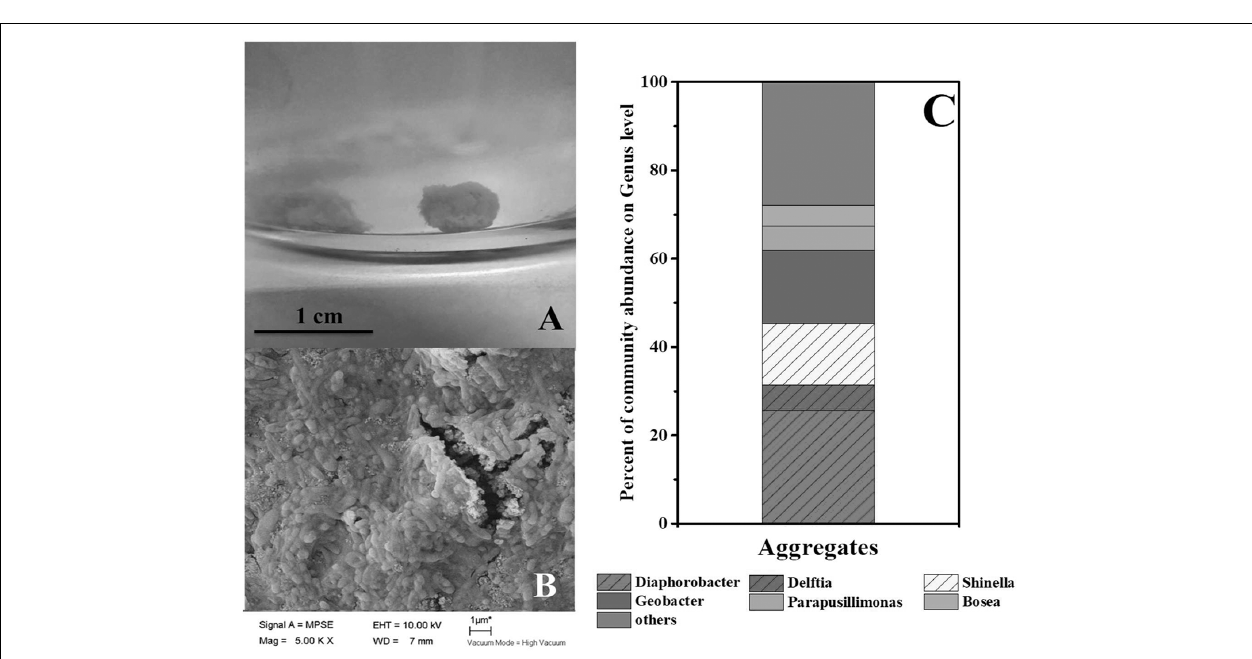
FIGURE 3 | Photo (A) and SEM image (B) of aggregates in G. sulfurreducens PCA added denitrifying microbial community. Relative abundance of microbial community at genus level in the pink aggregates (C)